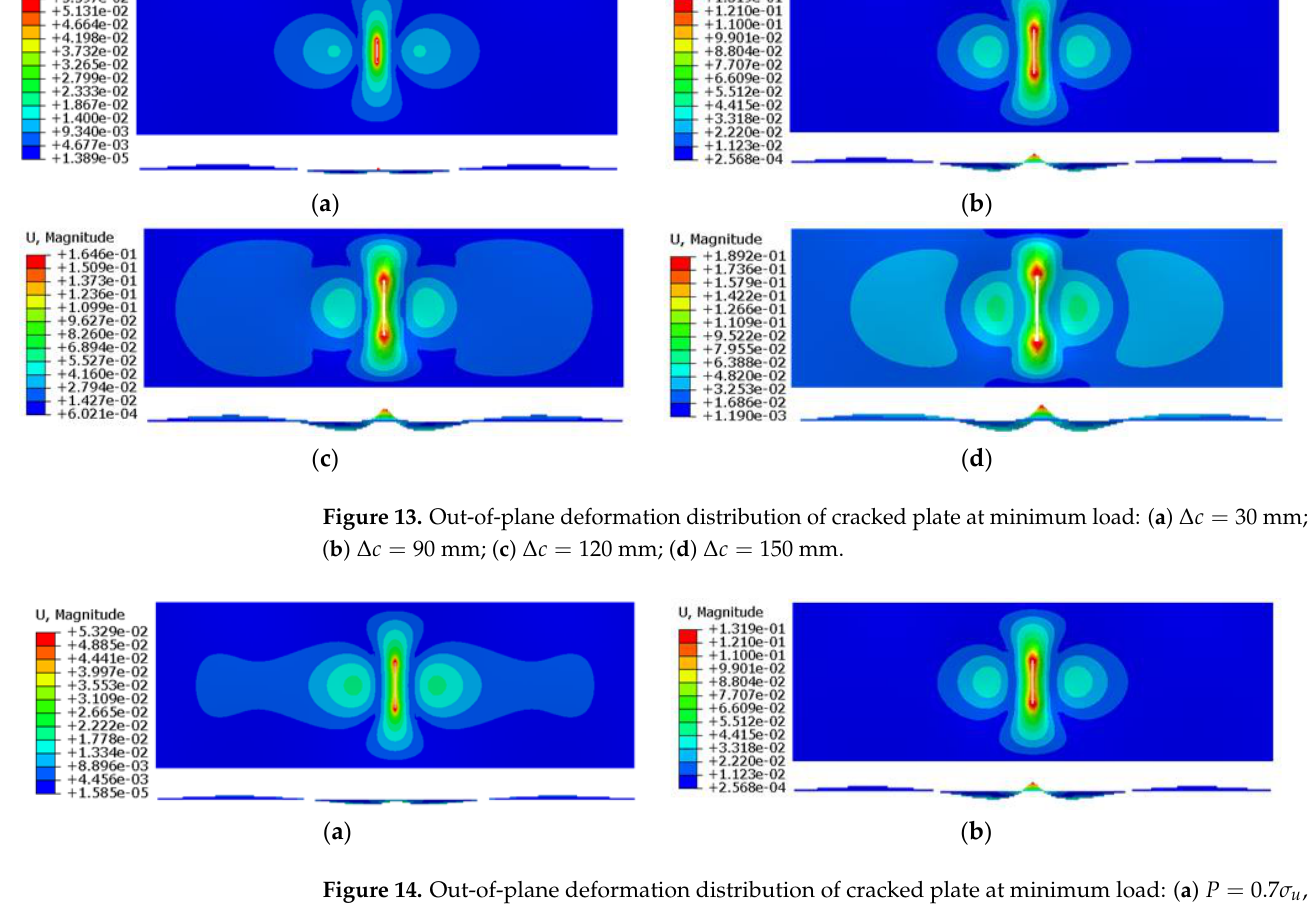
Figure 12. Stress distribution curve of the crack tip at different load levels for crack propagation length ∆𝑐 = 90 mm .